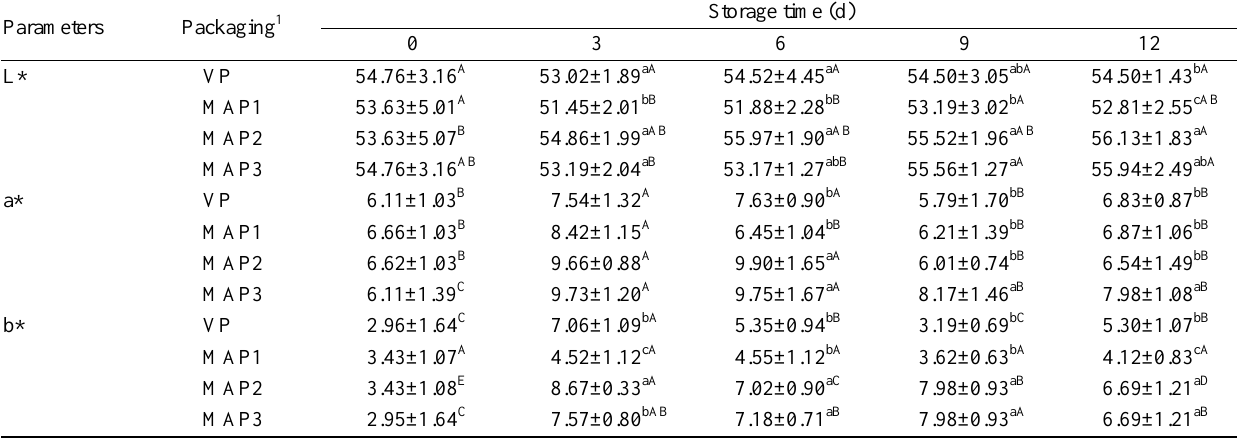
Table 1. Effect of gas composition in modified atmosphere packaging on pH and instrumental color of Longissimus dorsi of Korean Native Black Pig crossbred with Duroc during refrigerated